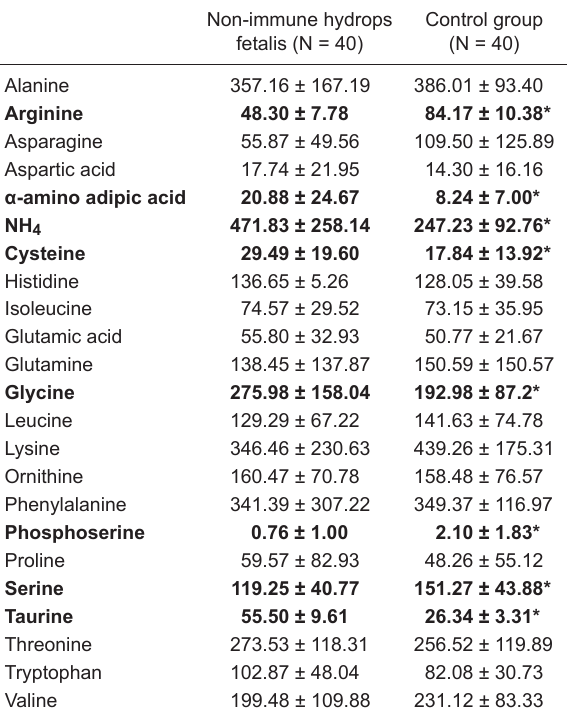
Table 2. Comparison of amniotic fluid amino acid levels between groups.